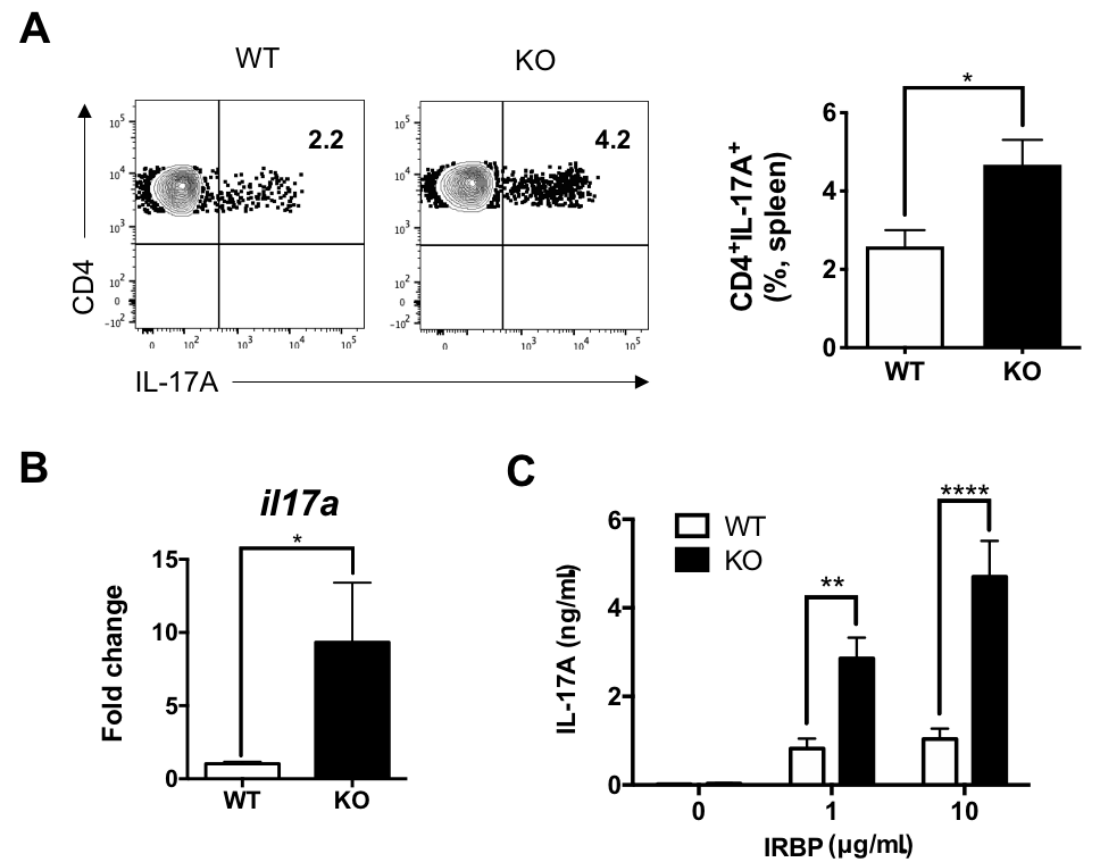
Figure 4. Peripheral Th17 response increased in IL-27Ra − / − EAU mice. ( A ) Representative plots and frequency of IL-17A- producing CD4 + T cells in the spleens from WT and KO EAU mice. Data represent the means ± SEMs of two experiments (WT: n = 5 mice; KO: n = 7 mice). * p < 0.05, Mann–Whitney U test. ( B ) The relative gene expression of il17a in CD4 + T cells sorted from the spleens of WT and KO EAU mice. Total RNA was extracted from CD4 + T cells that were sorted from the spleens of mice on day 21 post-immunization. Data represent the means ± SEMs from a representative of two experiments (4 mice per group). * p < 0.05, Mann–Whitney U test. ( C ) Retinal antigen-specific IL-17A production in dLNs of WT and KO EAU mice. Lymphocytes were isolated from dLNs and stimulated with IRBP for 48 h. Cultured supernatants were collected for cytokine determination by ELISA. Data represent the means ± SEMs of two experiments (WT: n = 5 mice; KO: n = 6 mice). ** p < 0.01, **** p < 0.0001, two-way